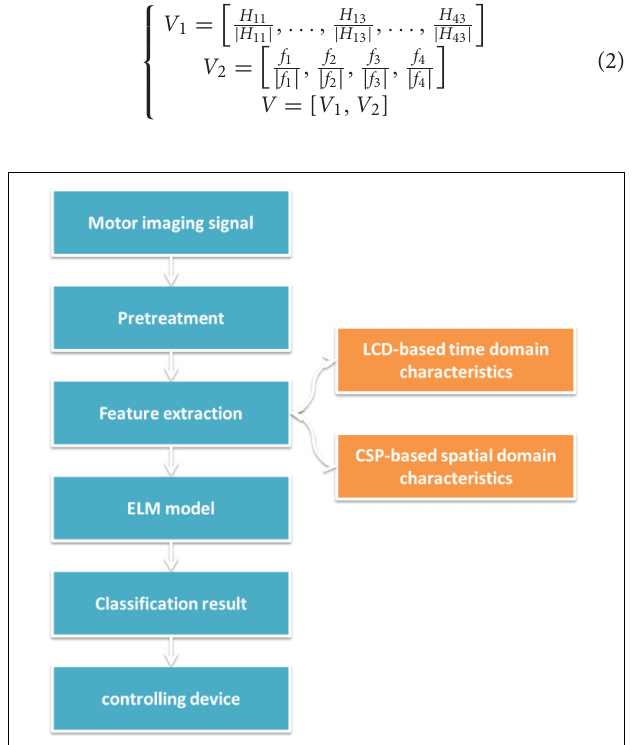
FIGURE 2 | Motion image recognition process based on ELM.